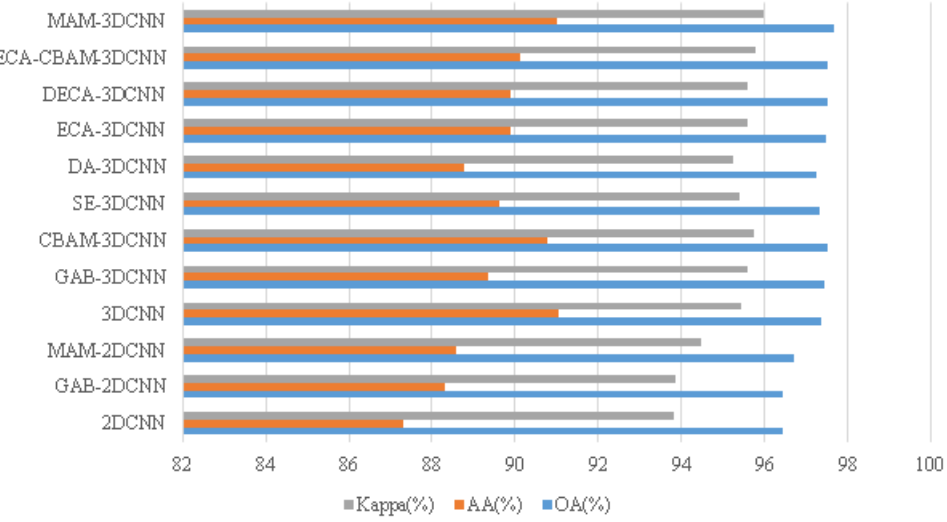
Figure 15. The values of the OA, AA, and Kappa of the considered methods.